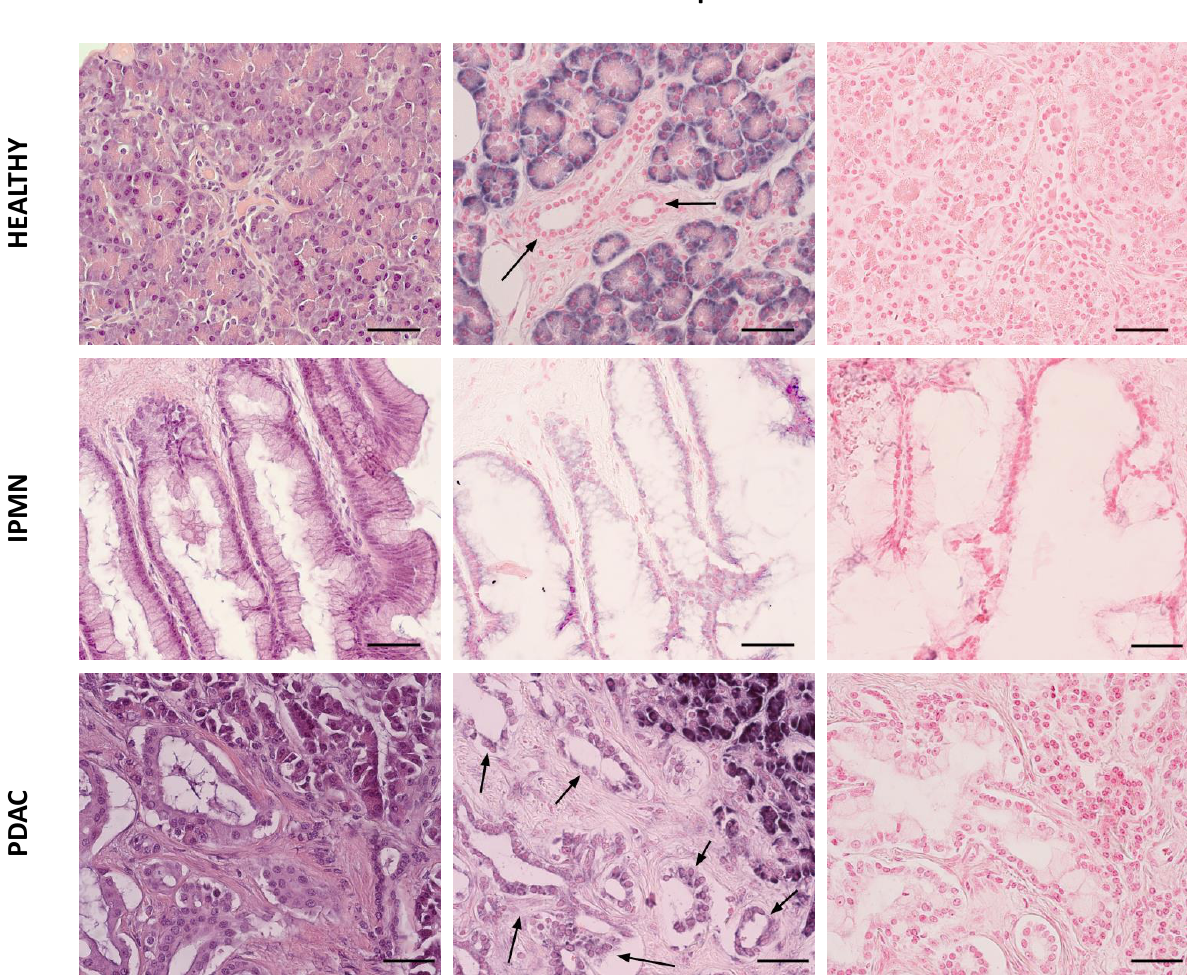
Figure 6. In situ hybridization of miR-181a-5p in Healthy, IPMN, and PDAC pancreatic tissues. From left to right: Representative haematoxylin-eosin staining of the analysed tissues. Representative images of LNA-miR-181a-5p probe and Scrambled miR-control probe staining. Arrows highlight ductal cells. High miR-181a-5p expression is shown as blue/purple, low expression is shown as light pink. Representative images from Healthy ( n = 4), IPMN ( n = 3) and PDAC ( n = 4) pancreatic tissues. Magnification: 40 × . Scale bars size 50 µ